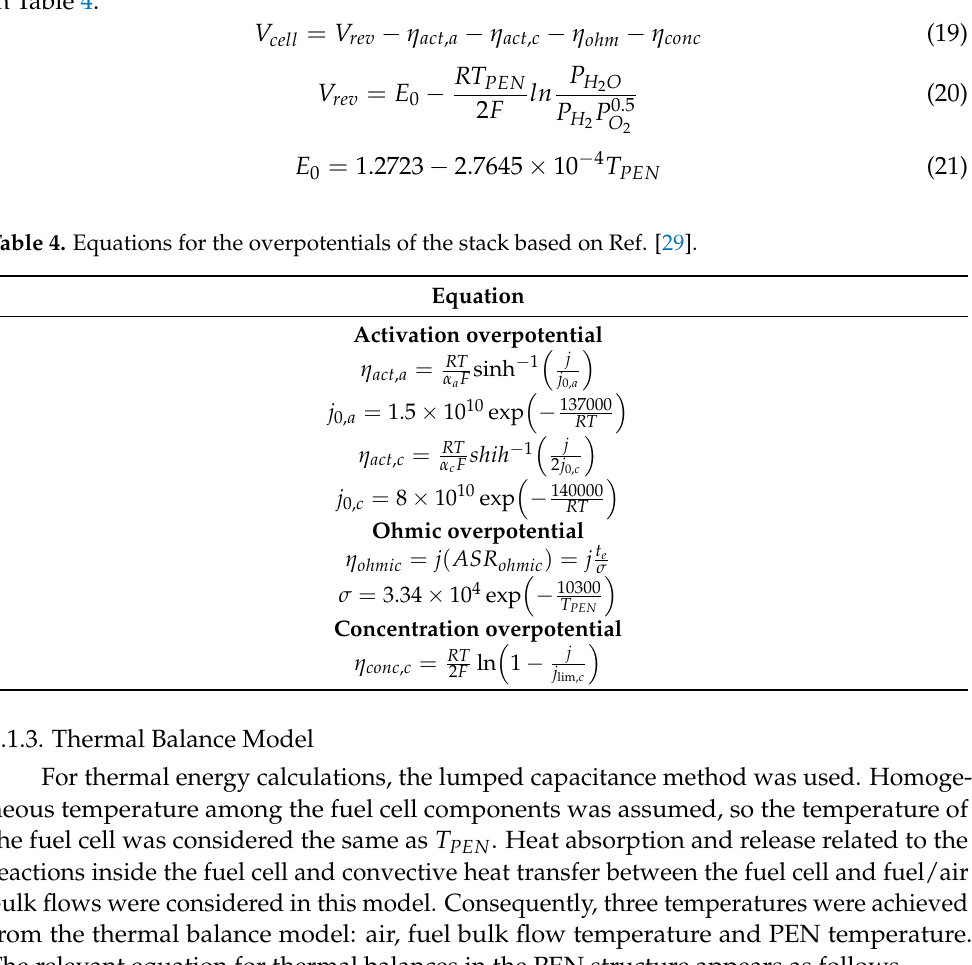
Table 4. Equations for the overpotentials of the stack based on Ref. [29].